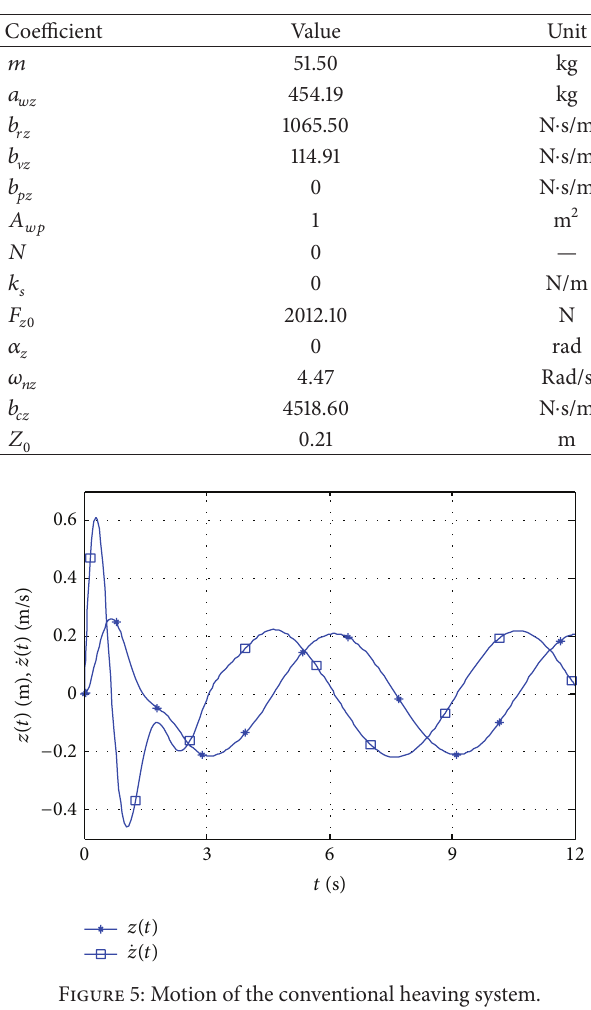
Table 1: Conventional heaving float coefficients.